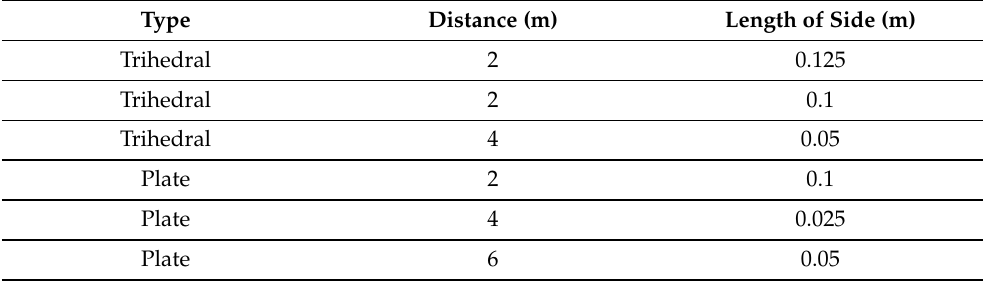
Table 3. The type of the targets.